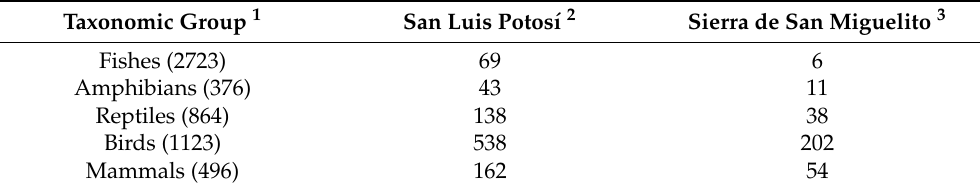
Table 1. Number of terrestrial vertebrate species reported for Mexico, San Luis Potosi and the Sierra de San